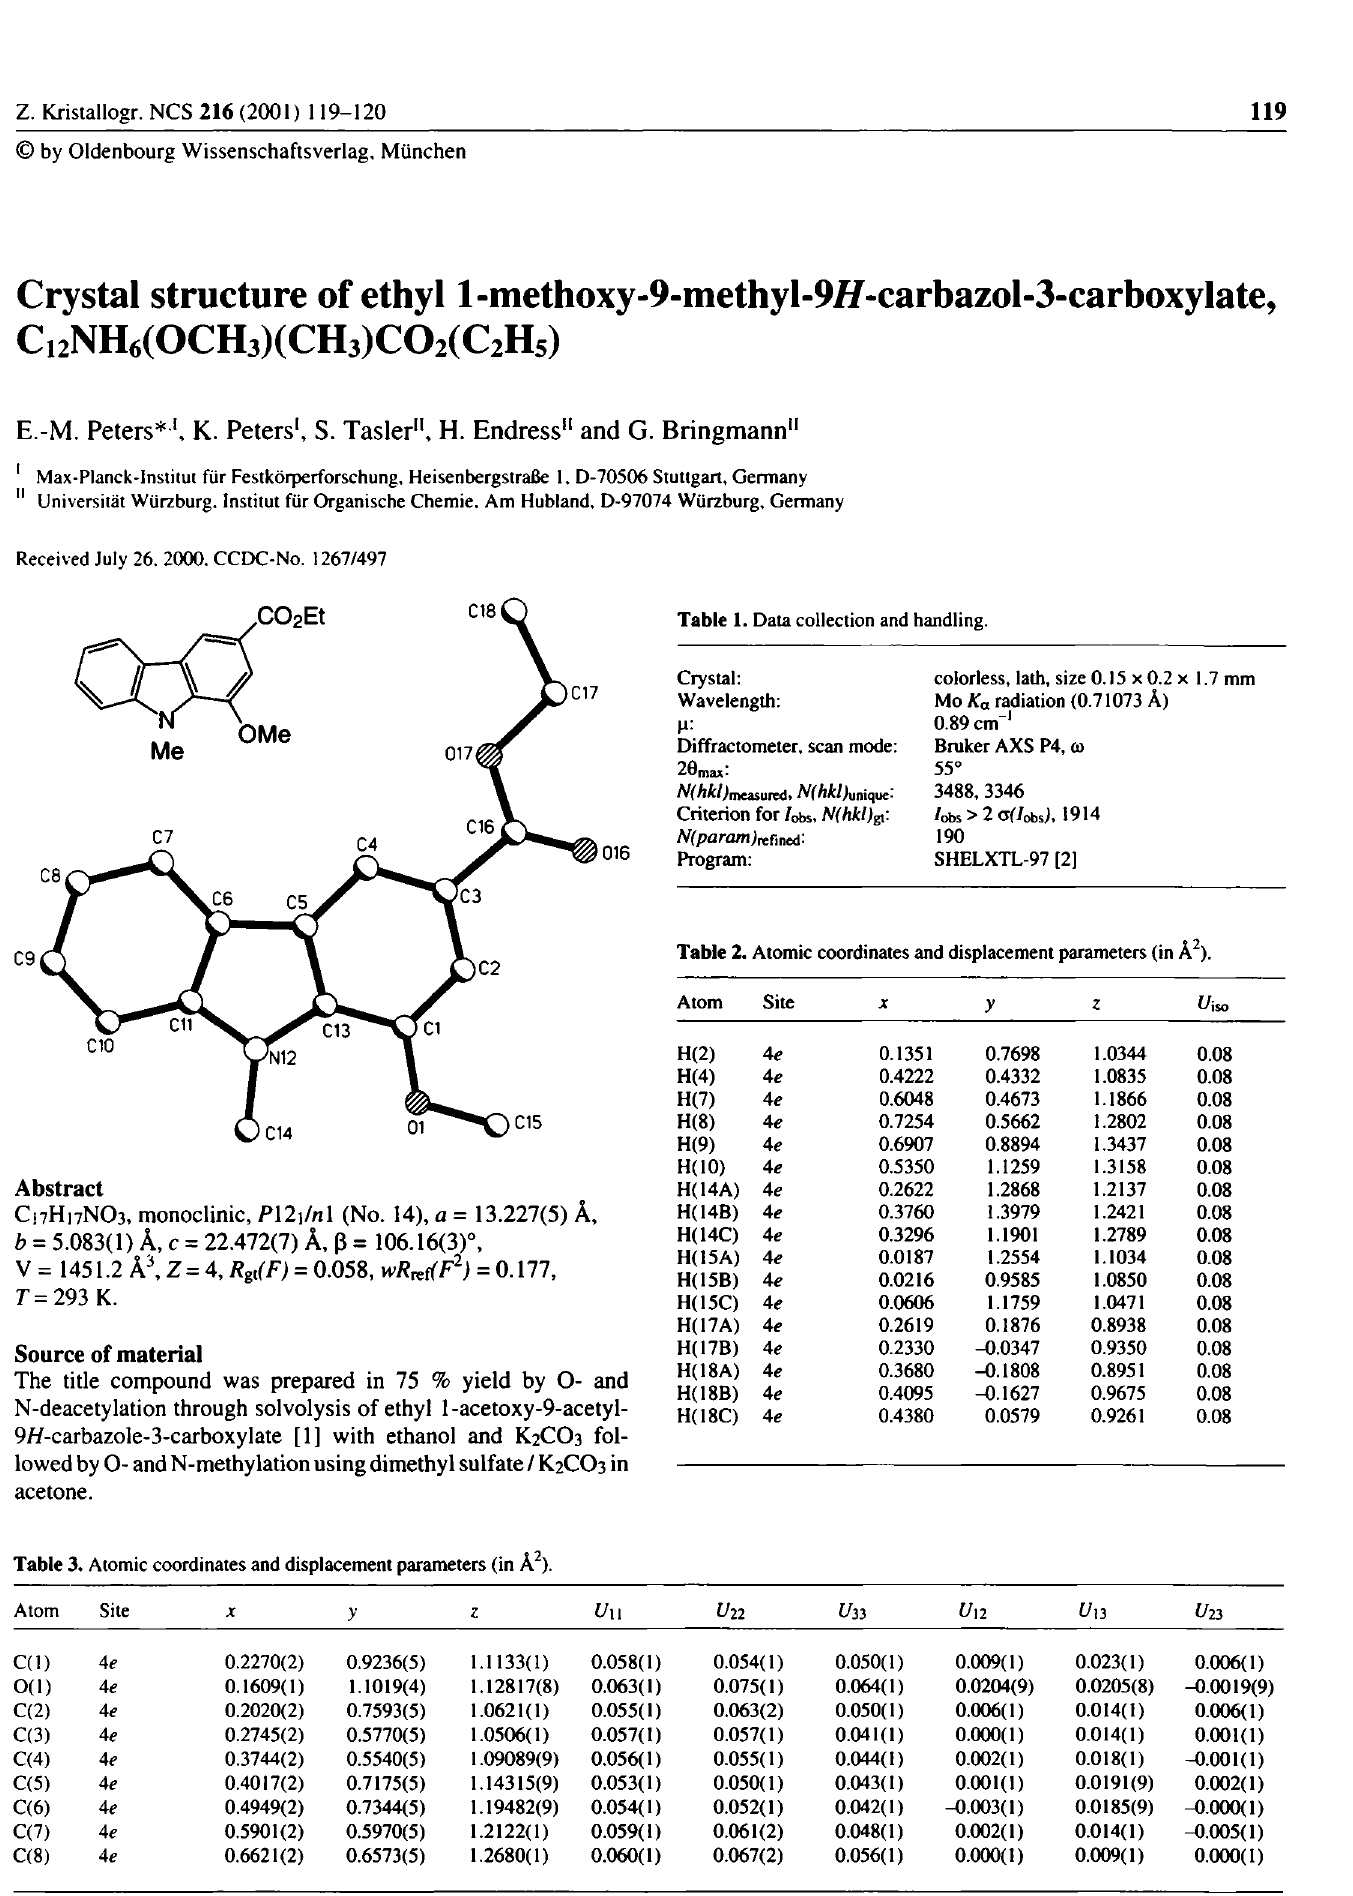
Table 3. Atomic coordinates and displacement parameters (in Ä 2